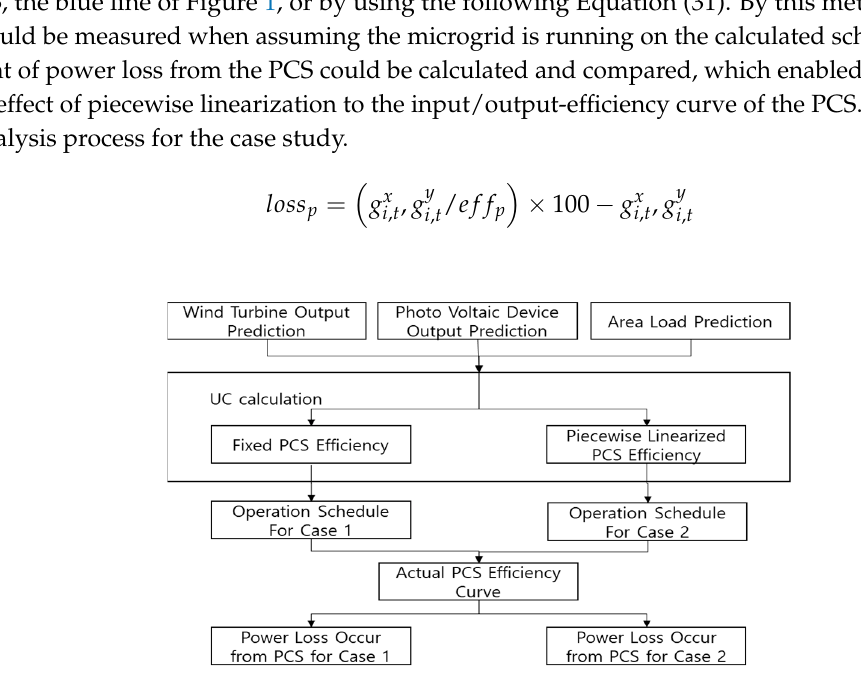
Figure 3. Input forecast data for case study.